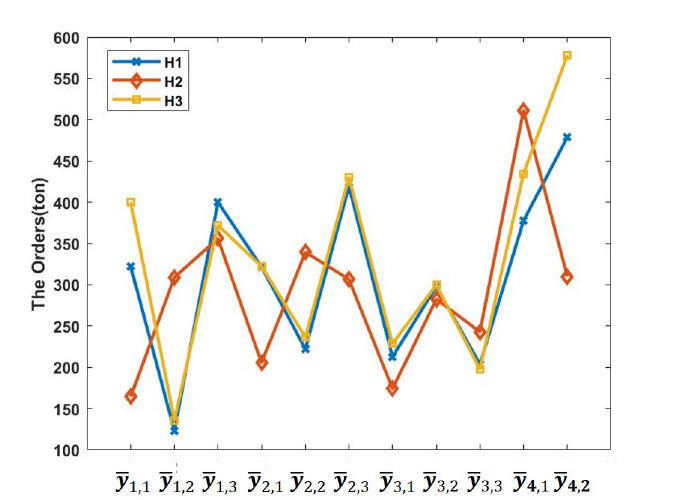
Figure 13. The values of the orders (ton) sent by the agent a l , v for getting Pareto solutions H 1 , H 2 and H 3